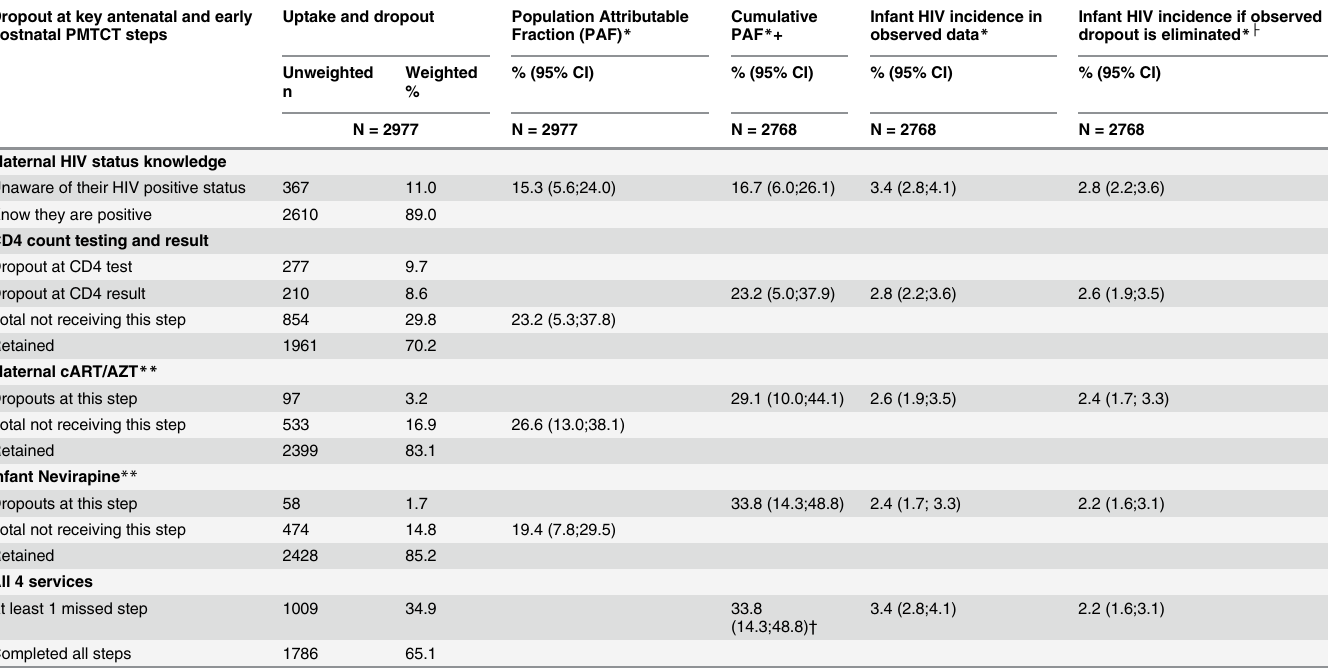
Table 2. Percentage of infant HIV transmission (at 4 – 8 weeks) attributable to dropouts along the PMTCT cascade, national survey, South Africa Dropout at key antenatal and early postnatal PMTCT